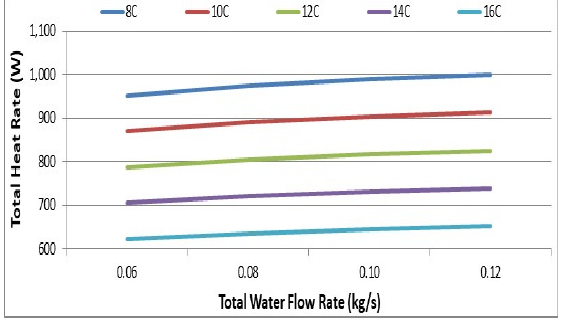
Fig. 3. The total heat rate of terminal units at 8, 10, 12, 14 and 16 °C water supply temperature and valve opening: Valve 1=100%, Valve 2=100% and Valve 3=100%.